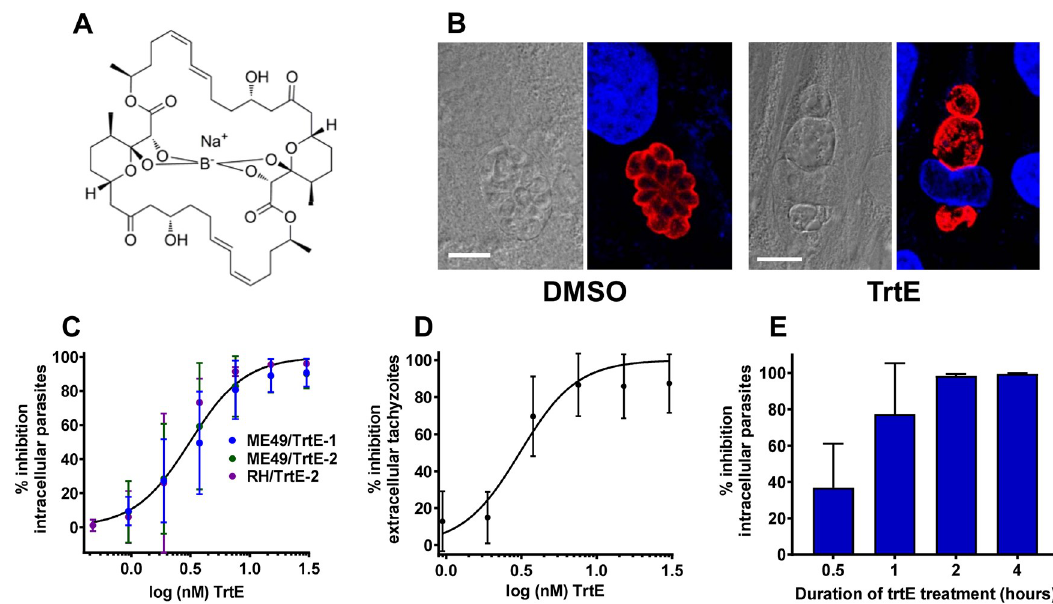
Fig 2. Tartrolon E has potent and rapid parasiticidal activity against intracellular and extracellular Toxoplasma gondii : A. Structure of trtE. B. HFF cells infected with T . gondii RH strain parasites were treated with DMSO vehicle control (left panels) or 60 nM trtE (right panels) for 24 hours. Infected cells were then fixed and processed for IFA. Left images show DIC images, right images show corresponding IFA (red = rabbit anti- T . gondii SAG1 antibody, blue = DAPI). Scale = 5 μ m. Images are enlarged from S7 Fig, panels A and B. The morphology of trtE-treated parasites is similar to that seen with T7901 culture supernatant (compare Figs 1 and 2, and S1 and S7). C. Luciferase expressing RH or ME49 strain T . gondii parasites were allowed to infect HFF cells for 24 hours, then the infected cells were treated with two-fold dilutions of trtE purified by method 1 (TrtE-1) or method 2 (TrtE-2). Parasite growth was quantified 24 post-treatment by luciferase expression. Data were analyzed using the log[inhibitor]vs response-Variable slope (four parameter) regression equation in Graphpad Prism and curves compared using the extra sum of squares F-test. One curve adequately fit all the data sets (p = .42) with an estimated EC 50 of 3.0 nM (95% CI of 2.5 to 3.5). D. Luciferase expressing RH strain tachyzoites, isolated from their host cells, were treated with two fold dilutions of trtE or DMSO control for 2 hours, then the compound was washed off and the parasites allowed to infect HFF cells for 24 hours. Parasite growth, as evaluated by luciferase expression, was inhibited by trtE treatment of tachyzoites with an EC 50 of 3.1 nM (analysis as for C ; 95% CI of 2.3–4.3). E: HFF cells were infected with luciferase expressing T . gondii ME49 strain for 24 hours. Infected cells were then treated with 30 nM trtE or DMSO control for 0.5 to 4 hours, at which times the compound was washed off the infected cells. Parasite growth was evaluated by luciferase expression 72 hours after treatment. Parasites were killed after 2 hours of trtE